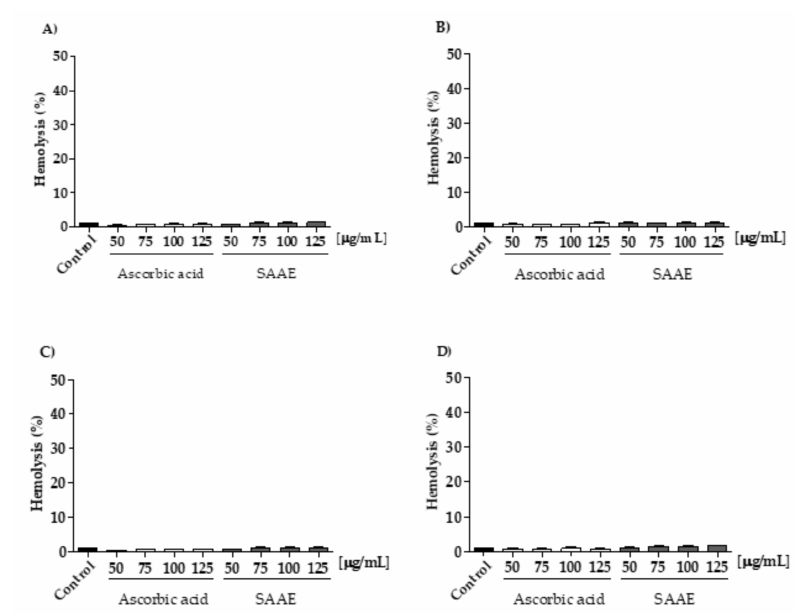
Figure 3. Assessment of hemolysis in human erythrocytes incubated for ( A ) 60, ( B ) 120, ( C ) 180 and ( D ) 240 min with different concentrations of ascorbic acid and the SAAE (50–125 µ g/mL). Data are expressed as the mean ± SEM ( n = 3) in duplicates.